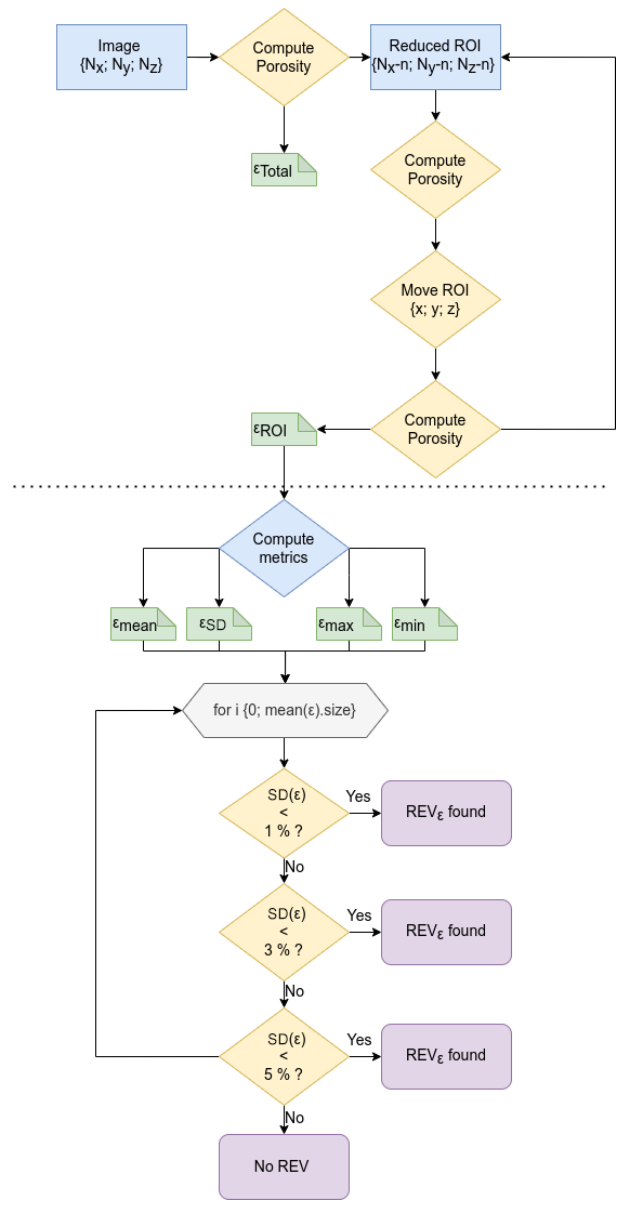
Figure 3. Flowchart of the representative elementary volume of porosity (REV ε ) from a binarized image. For each sample, three thresholds are tested (5%, 3% and 1% and standard deviation vari-